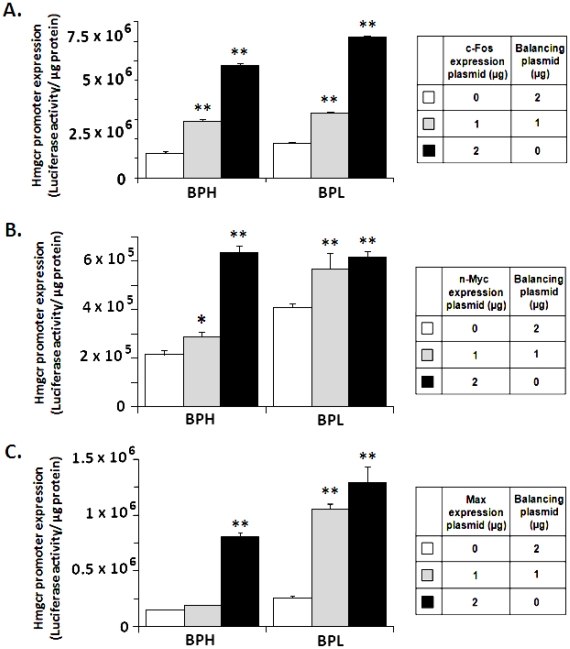
Activation of Hmgcr promoter activity by over-expression of c-Fos, n-Myc and Max.CHO cells were transiently transfected with increasing quantities (0–2.0 µg/well) of expression plasmids for the transcription factors c-Fos (Panel A), n-Myc (Panel B) or Max (Panel C) and 1.0 µg/well of BPL/BPH Hmgcr promoter (−961 to +43 bp)/firefly luciferase construct in 12-well cell culture plates. The total amount of plasmid DNA transfected to each well was made equal by using balancing amounts of the backbone plasmids (viz. pMiwSV plasmid in the cases of n-Myc/Max co-transfection and pSGI plasmid in the case of c-Fos co-transfection). Cells were lysed 24–30 hrs after transfection and assayed for luciferase activity. The results are expressed as ratios of firefly luciferase activity/µg protein and are the mean ± SE (n = 3–4 transfections for each construct). Although both BPL and BPH promoters displayed, in general, activation by each of these three transcription factors in a dose-dependent manner with respect to the control, the extents of activations were greater in case of BPL. (**) and (*) indicate p<0.01 and p<0.05 respectively with respect to the corresponding mock (i.e., without a co-transfected transcription factor). Co-transfection of Max expression plasmid resulted in more dramatic difference in promoter activities between BPL and BPH while the c-Fos expression plasmid showed the least difference in promoter activities, especially at the equimolar dose (1.0 µg/well transcription factor along with 1.0 µg/well promoter/reporter).